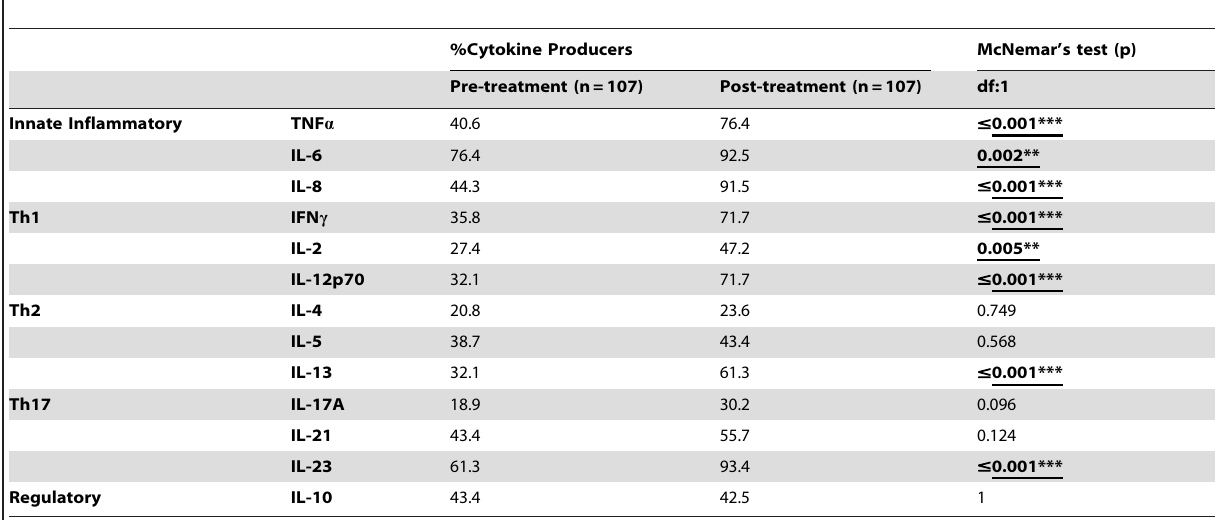
Table 4. Paired comparison of the percentage of participants producing detectable levels of GST-specific cytokines before and 6 weeks after PZQ